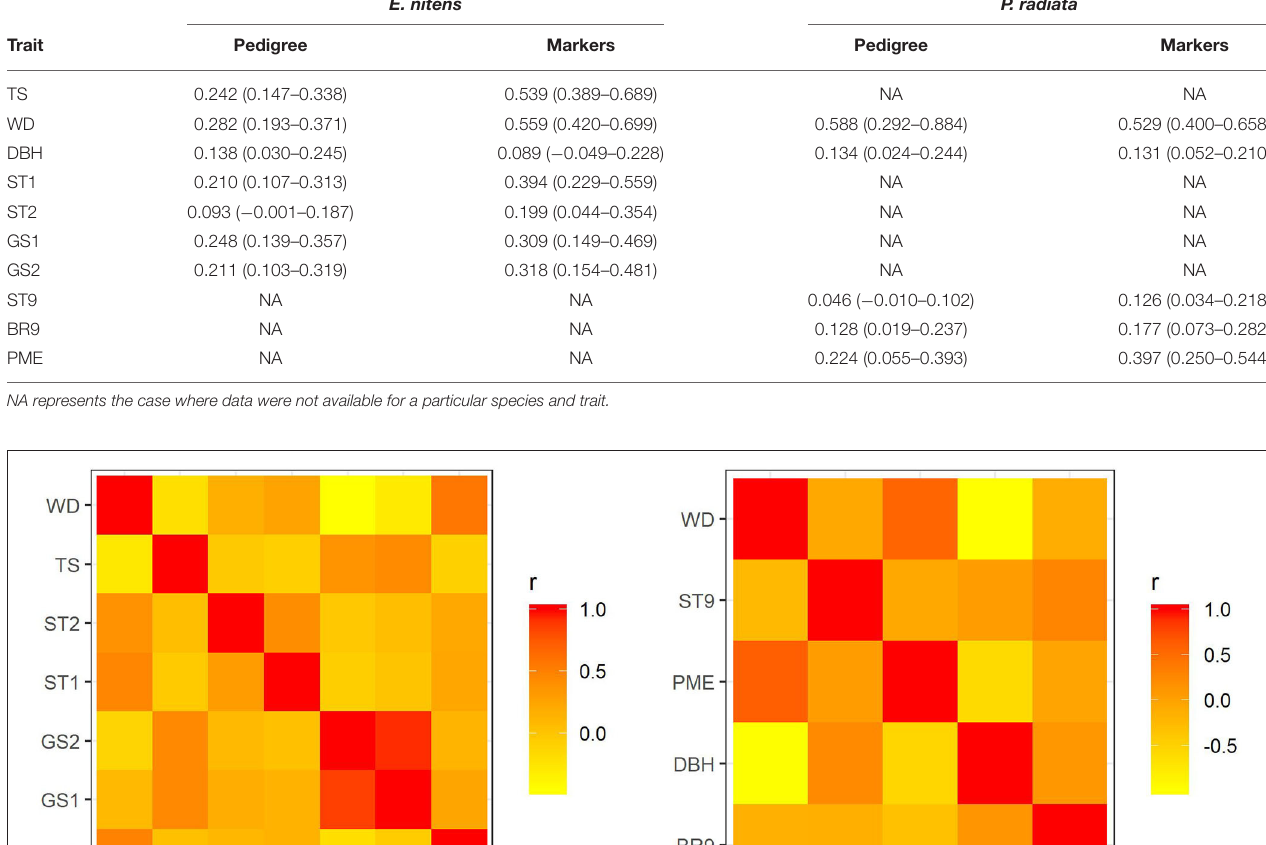
TABLE 1 | Heritability estimates and their 95% confidence limits using variance components inferred from the sib-ship reconstruction-based univariate model (BLUP) in E. nitens and from using the pedigree-based univariate model (BLUP) in P. radiata as well as marker-based univariate models (GBLUP). E. nitens